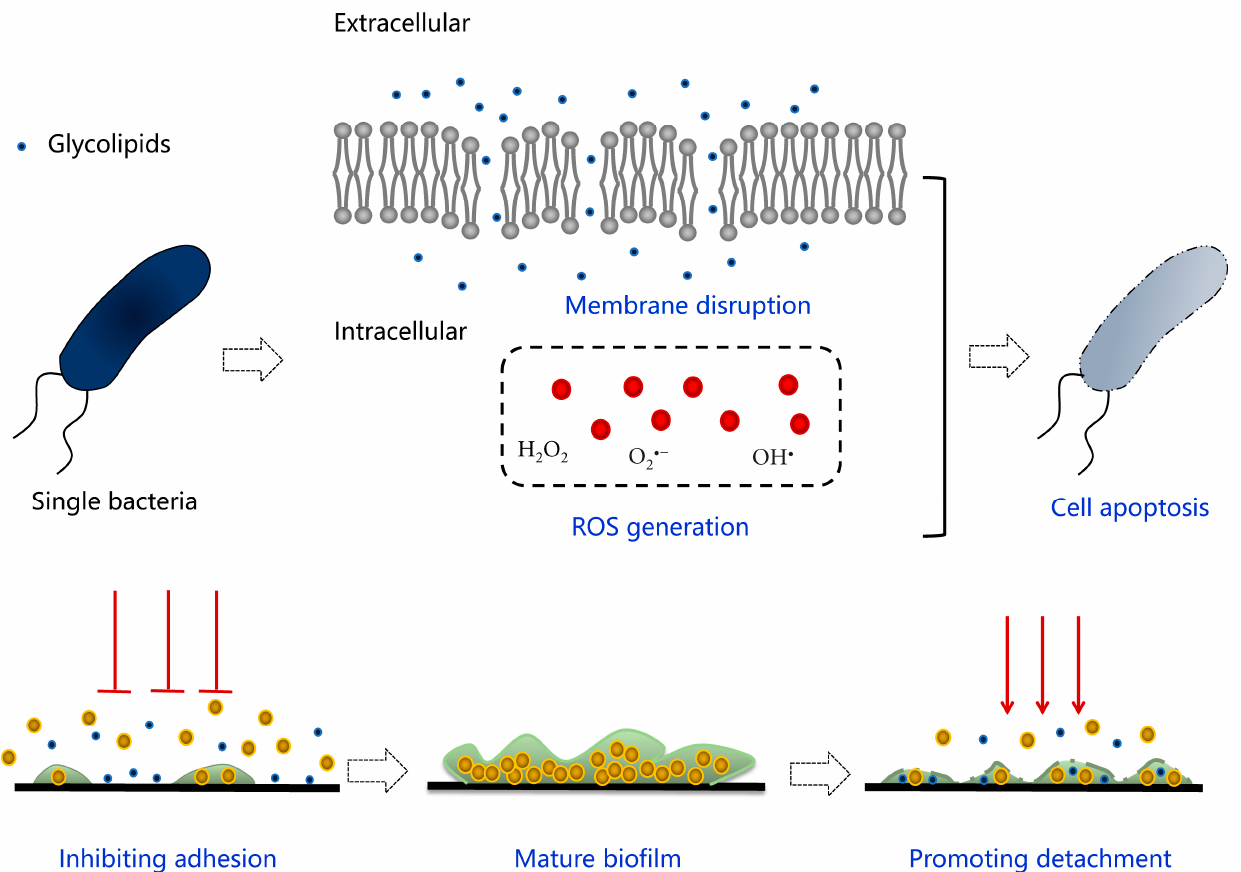
Figure 7. Schematic diagram of the antimicrobial mechanism of glycolipids involved in planktonic cells and biofilms. Nano-scale approaches have been rapidly progressed and attract concentration glob- ally on controlling microbial contamination in medical and healthcare applications. Nano- carriers (such as nanoparticles and liposomes) are regarded as crucial drug delivery sys- tems due to their great dispersity, high encapsulation efficiency, and stability. Glycolipids have been reported to play an important role in the modification of these materials both structurally and functionally, relying on their special amphipathicity and self-assembling activity as well as various biological activities. Therefore, the antimicrobial effect of gly- colipid-modified material has been augmented evidently because of the combination of effective compounds. The modification of new materials based on glycolipids prompts the exploitation of novel antimicrobial agents applicable to different requirements. Furthermore, the synergic work of glycolipids and antibiotics or other antimicrobials on microorganisms is on trial and has made initial progress. Sophorolipids was confirmed